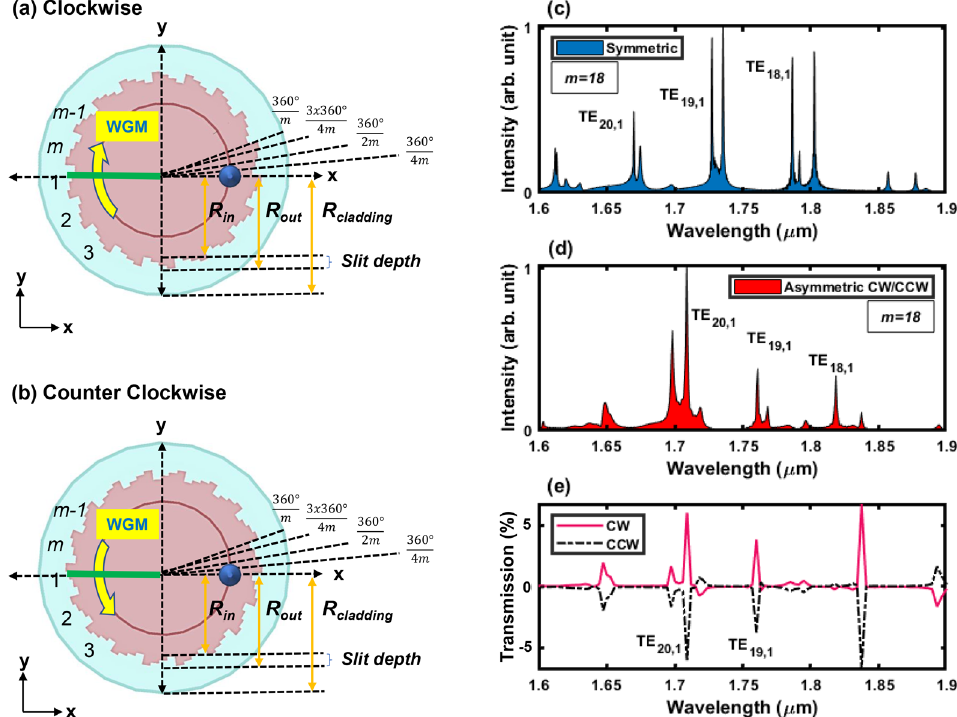
Figure 4. Asymmetric micro-gear cavities promoting ( a ) clockwise, and ( b ) counter clockwise whispering- gallery modes (WGM) rotation. Each gear-tooth is divided into 4 segments with a different radius resulting in staircase or triangular-shaped periods. ( c ) Simulated spectrum of a symmetric micro-gear as shown in Fig. 1a, m = 18 . ( d ) Simulated spectrum of CW or CCW asymmetric micro-gear cavities with 18 periods ( m = 18 ). ( e ) Simulated transmission of the WGMs in CW and CCW asymmetric micro-gears ( m = 18 ) captured through the cross-section of the cavity as they pass at the location of the yellow arrow in ( a , b ). Transmission is defined as the normalized power flow through the cross-sectional area of the cavity through a monitor that is placed at the position marked by the solid green line in ( a , b ) extending from x = − 2.25 to 0 µ m, and y = 0 µ m. Positive (negative) transmission sign means a power flow towards the positive (negative) y-axis through the monitor surface area. The fields are equal in magnitude but opposite in direction confirming reversing the WGM propagation by asymmetry. The excitation source is placed at the position marked by the blue circle on the positive x axis (at y = 0 and x = R in − 100